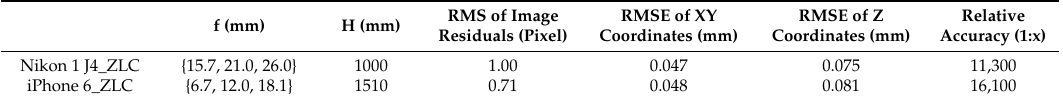
Table 3. Zoom lens vs mono-focal calibrations in terms of derived accuracy.